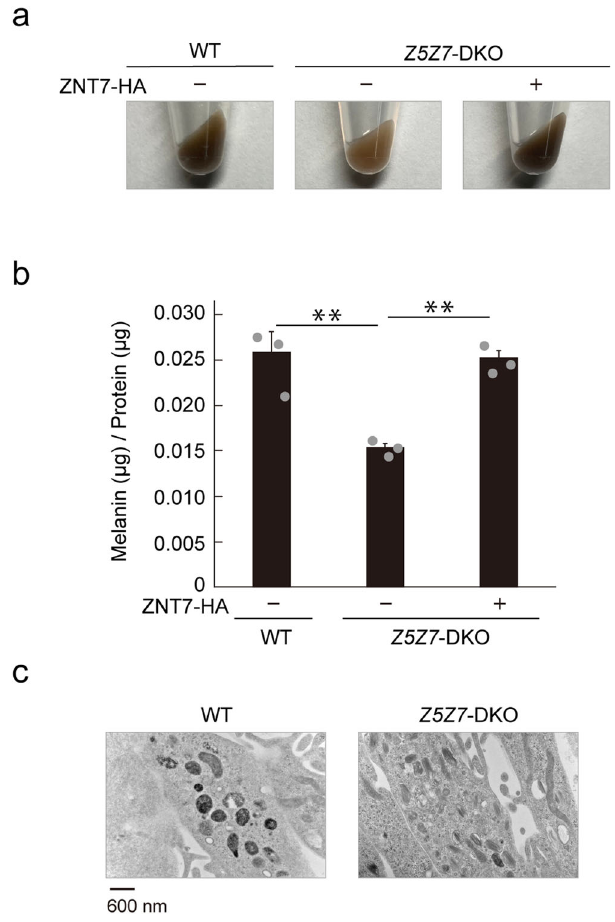
Fig. 2 Melanin synthesis is decreased in Mewo- Z5Z7 -DKO cells. a Pellets of wild-type (WT) Mewo and Mewo- Z5Z7 -DKO cells, and of Mewo- Z5Z7 - DKO cells stably re-expressing ZNT7-HA. b Melanin content was decreased in Mewo- Z5Z7 -DKO cells compared with that in WT Mewo cells; the decrease was recovered upon expression of ZNT7 ( n = 3). Statistical signi fi cance was determined using the one-way analysis of variance (ANOVA) followed by Tukey ’ s post hoc test. ** p < 0.01. c Transmission electron microscopy (TEM) showing irregular melanosomes with less electron dense pigment in Mewo- Z5Z7 -DKO cells compared with those in WT Mewo cells. Each experiment, except for that in c , was performed at least three times, and representative results from independent experiments are shown. Panels in c show representative results for at least three cells.